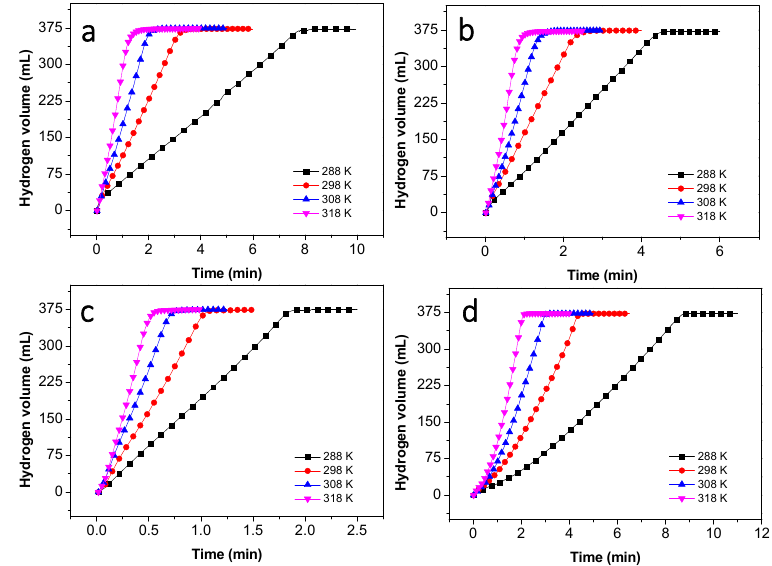
Figure 11. HG kinetics curves for the initial stage of the hydrolysis of 1.5 wt % NaBH 4 at different solution temperatures using Co–B catalysts prepared in ( a ) water; ( b ) methanol; ( c ) acetone; and ( d ) acetonitrile.